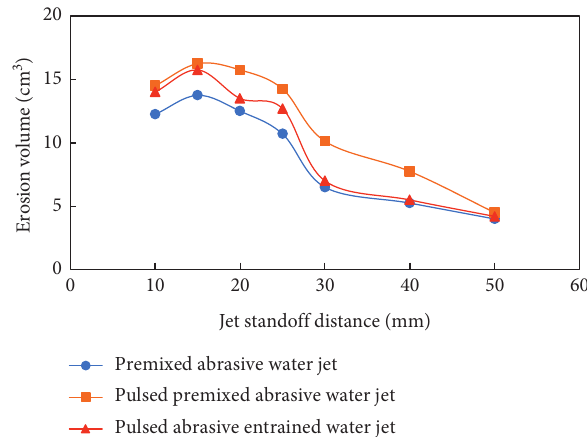
Figure 6: Erosion performance of the three kinds of abrasive water jets (when the pump pressure is 15MPa and the abrasive con- centration is 1%).